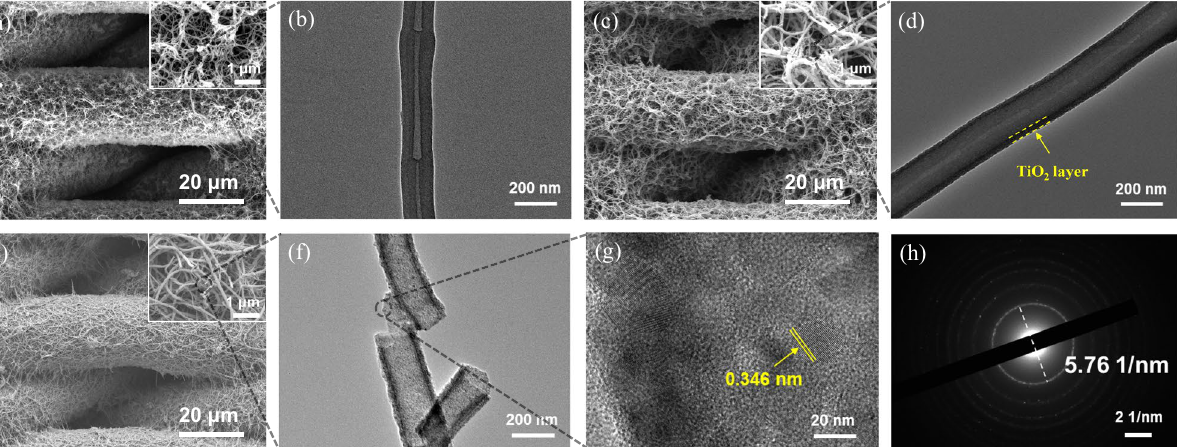
Figure 2. ( a ) SEM image of P(DVB-CH 2 N + Cl − ) nanofibers coated mesh; ( b ) TEM image of P(DVB-CH 2 N + Cl − ) nanofiber; ( c ) SEM image of P(DVB-CH 2 N + Cl − )@TiO 2 nanofibers coated mesh; ( d ) TEM image of P(DVB- CH 2 N + Cl − )@TiO 2 nanofiber; ( e ) SEM image of TN450 coated mesh; ( f ) TEM image of TiO 2 hollow nanofiber; ( g ) high resolution TEM image of TiO 2 hollow nanofiber; ( h ) the corresponding selected-area electron diffraction pattern.